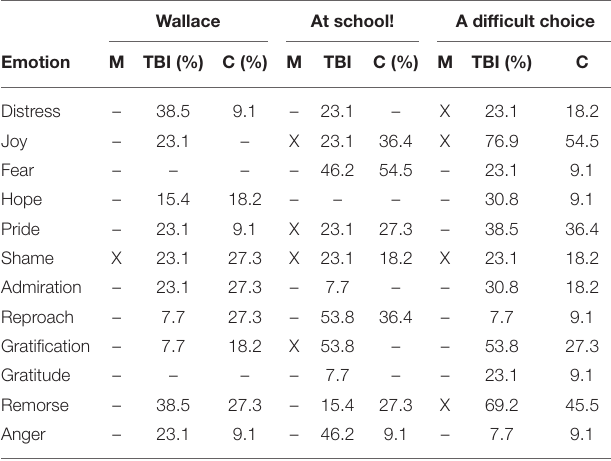
TABLE 2 | Actor studio: percentages for emotion choice. Wallace At school!